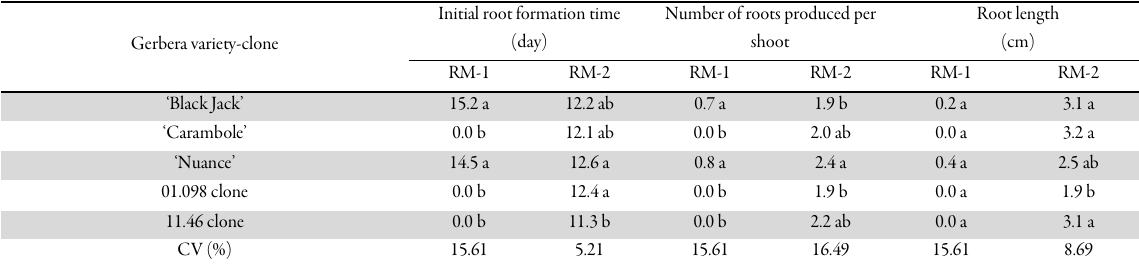
Table 8. Interaction effect of responses of Gerbera varieties-clones and rooting media on number of roots produced per shoot Gerbera variety-clone